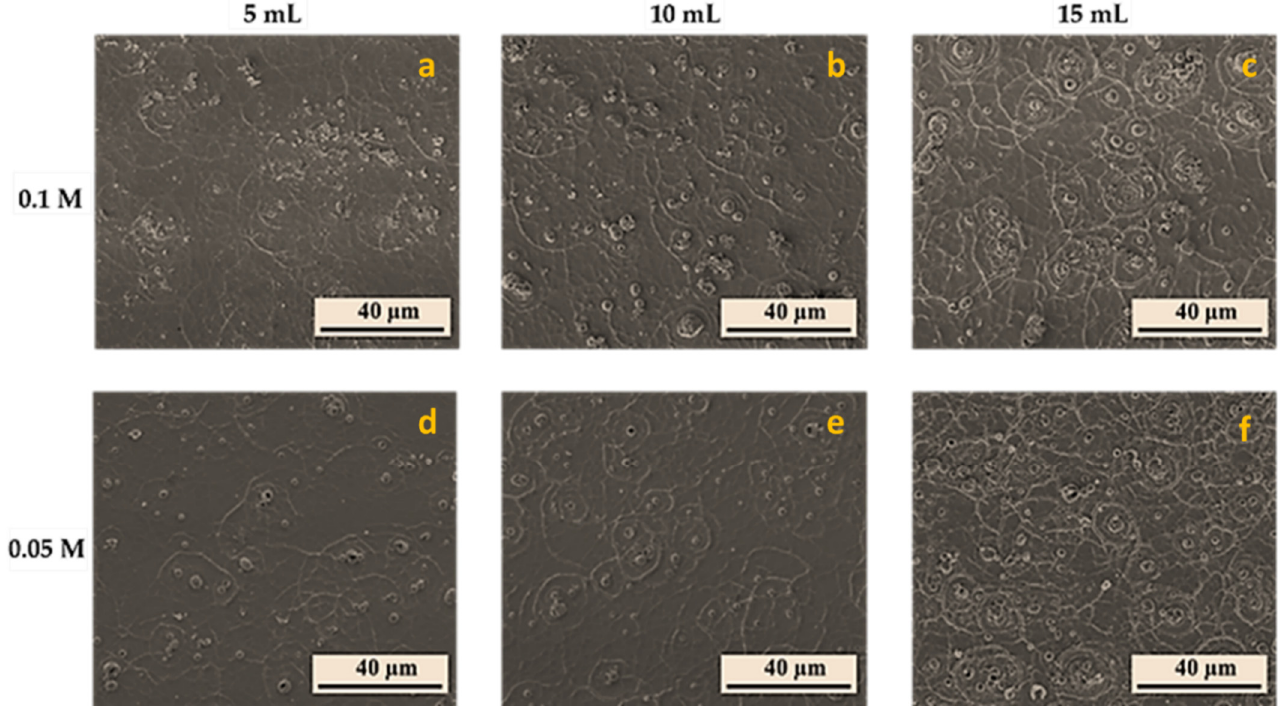
Figure 6. Surface morphology of WO 3 thin films studied in this work–FE-SEM images of WO 3 coatings grown from precursors: ( a ) 5 mL with 0.1 M; ( b ) 10 mL with 0.1 M; ( c ) 15 mL with 0.1 M; ( d ) 5 mL with 0.05 M; ( e ) 10 mL with 0.05 M; ( f ) 15 mL with 0.05 M.